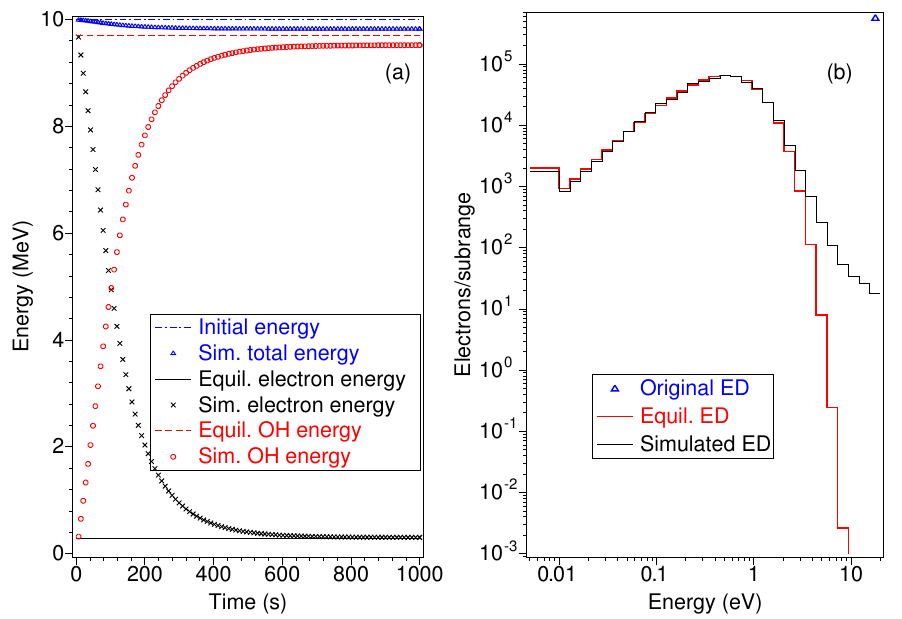
Figure 3. Simulated (symbols) and equilibrium (lines) values of ( a ) gas, electron and total energies for N = 30 with a logarithmic distribution of subrange boundaries. The simulated values are plotted as a function of time at every thousandth time step. The electron distributions ( b ) are shown for the original ( (cid:52) ), predicted equilibrium (thick line) and simulated at 1000 s (thin